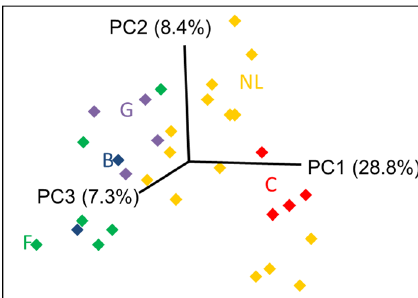
Figure 4. PCA scores plot of the PTR-MS (proton transfer reaction mass spectrometry) data (normalized and auto-scaled) of C. majalis from the five countries (Belgium (B, blue), China (C, red), France (F, green), Germany (G, purple) and The Netherlands (NL,